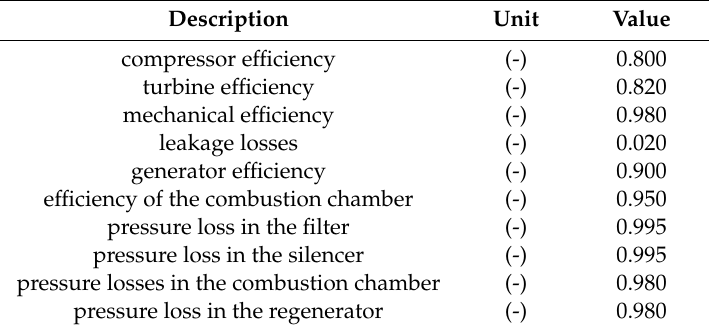
Table 1. Assumptions adopted for the design analysis of turbine generator variants